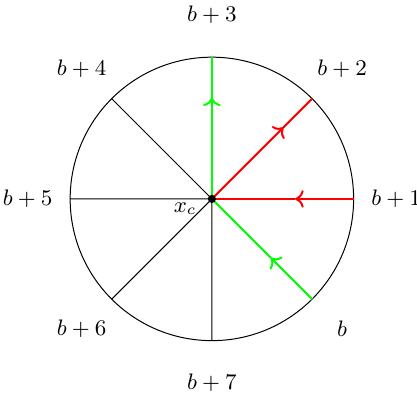
Figure 2 . Pictorial representation for elementary branes for the case W = X 8 . The red lines represent an elementary brane ( b + 1 , x c , b + 2) , the green lines represent a bound state ( b, x c , b + 3) of three neighboring branes corresponding to smallest